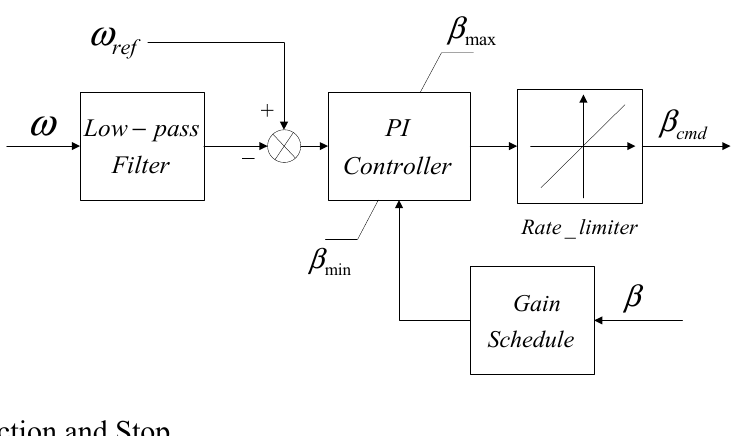
Figure 4. Schematic diagram of pitch angle